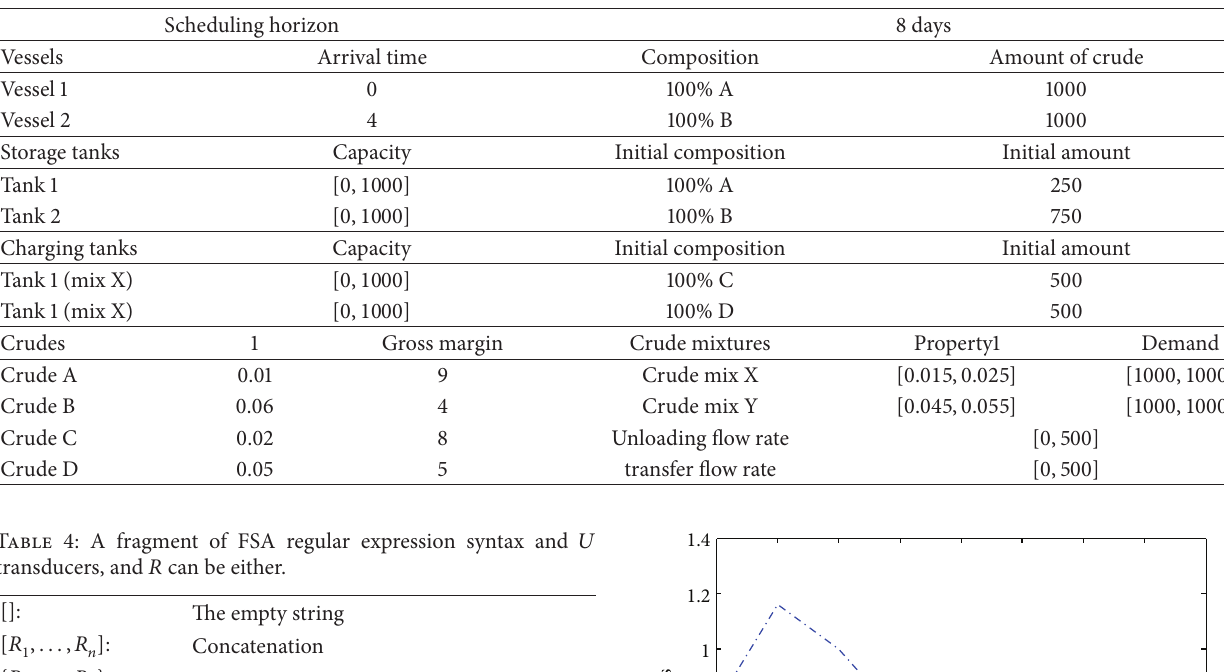
Table 3: Problem data.